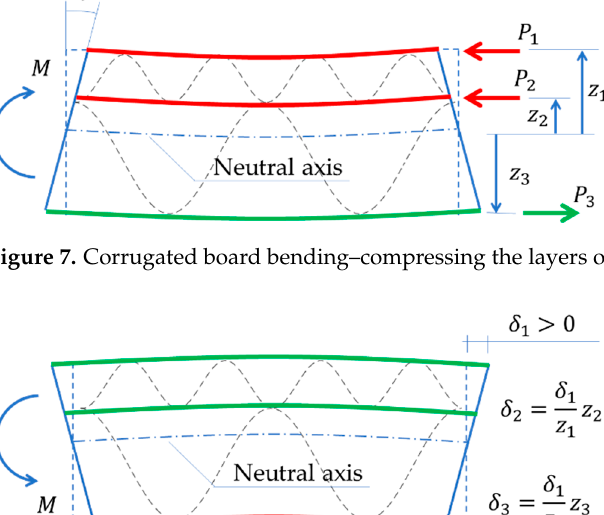
Figure 7. Corrugated board bending–compressing the layers of lower fluting.